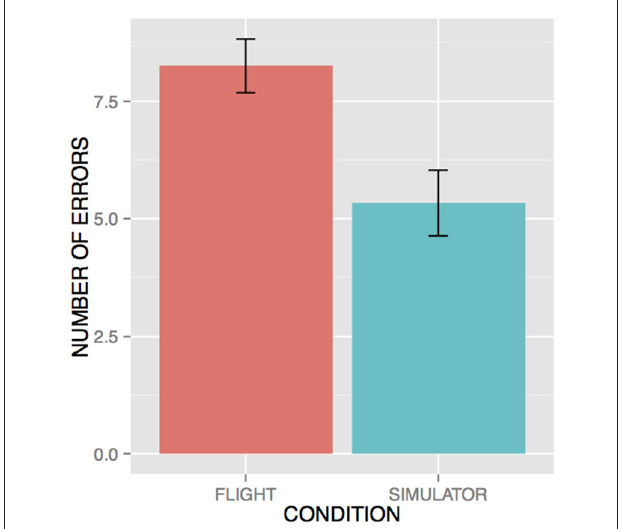
FIGURE 10 | The mean frontal 1 [ HbO 2 ] peak response (peak value within 30 s post-trial onset minus 2s average pre-trial onset) over the four ROIs of the PFC (from 1 - left to 4 - right) across WM loads and flight conditions.